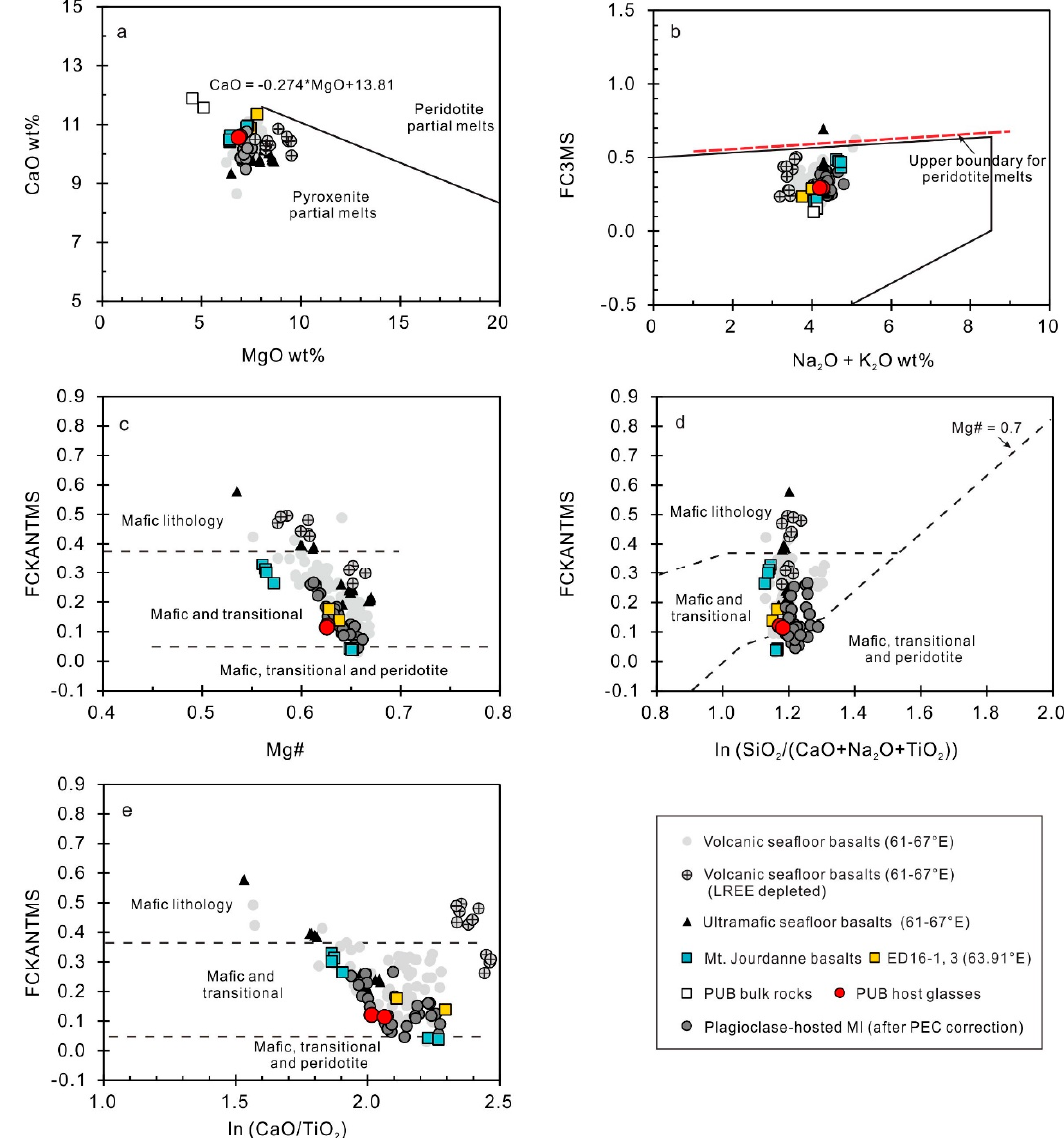
Figure 7. ( a ) CaO versus MgO, ( b ) FC3MS versus Na 2 O + K 2 O and FCKANTMS versus, ( c ) Mg#, ( d ) ln (SiO 2 /(CaO + Na 2 O + TiO 2 )) and ( e ) ln (CaO/TiO 2 ) for Mount Jourdanne basalts and PUBs, plagioclase-hosted melt inclusions and regional basalts from SWIR (61–67° E). FC3MS = FeO/CaO − 3 × MgO/SiO 2 , all in wt % [65]. FCKANTMS = ln (FeO/CaO) − 0.08 × ln(K 2 O/Al 2 O 3 ) − 0.052 × ln (TiO 2 /Na 2 O) − 0.036 × ln (Na 2 O/K 2 O) × ln (Na 2 O/TiO 2 ) − 0.062 × (ln (MgO/SiO 2 )) 3 − 0.641 × (ln (MgO/SiO 2 )) 2 − 1.871 × ln (MgO/SiO 2 ) − 1.473, all in wt % [61] . The solid line in ( a ) is an experimental divide between peridotite and pyroxenite partial melts [64]. The red dashed line in ( b ) is upper limit